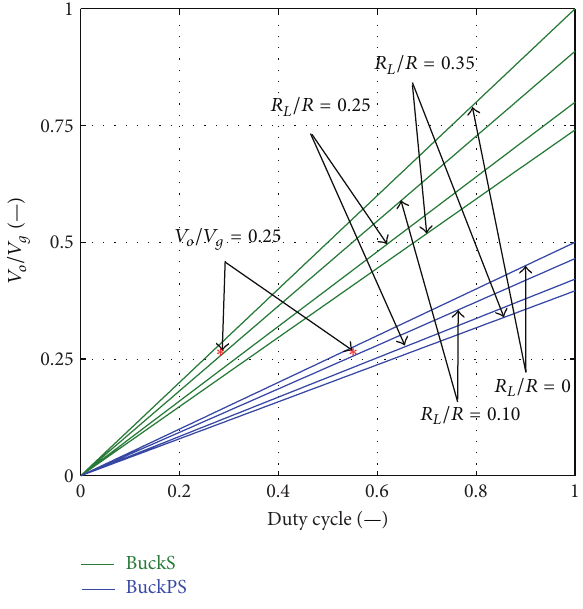
Figure 5: Conversion ratio of BuckPS and